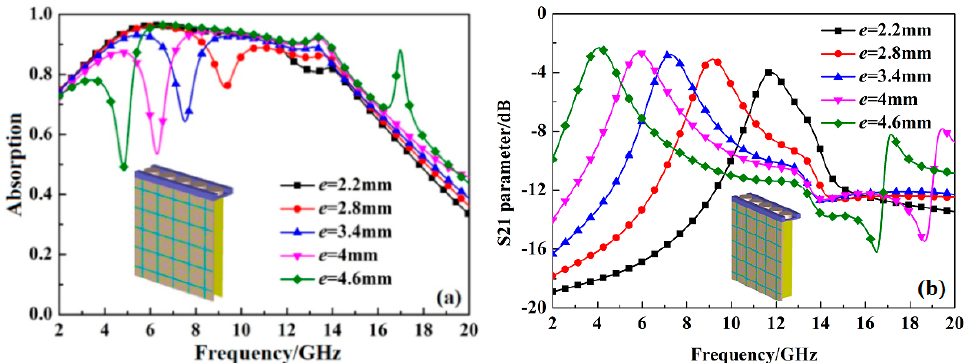
Figure 10. The absorption and transmission coefficient at different size parameter e , ( a ) the absorption, ( b ) the transmission coefficient.